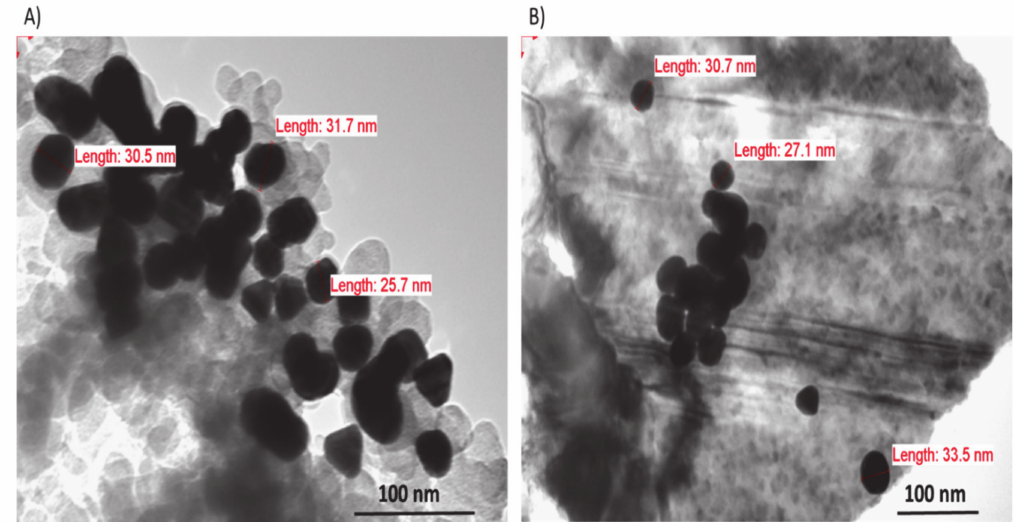
Figure 5. TEM image of SA-Au NPs showing the spherical shape of prepared with different individual particle sizes. ( A ) Measurement at a magnification of 300,000 × ; ( B ) Measurement at a magnification of 200,000 ×